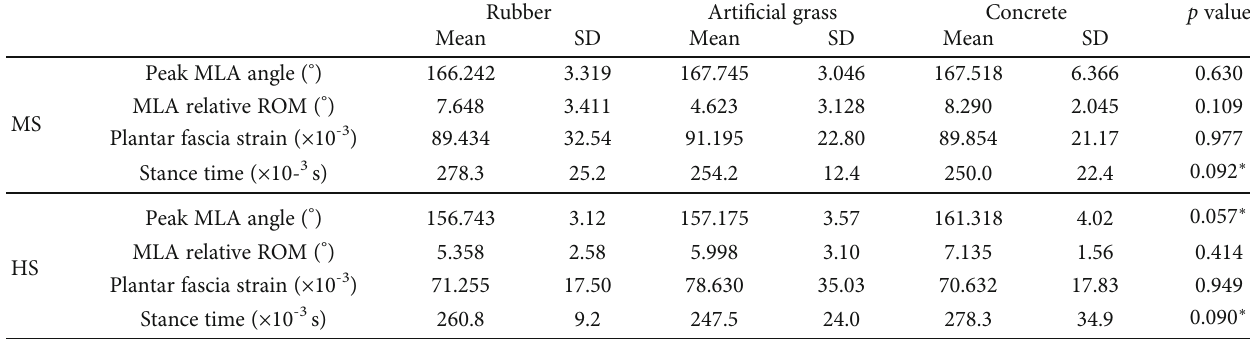
Table 3: E ff ects of running surface on peak MLA, MLA, relative to ROM, PFS, and stance time.